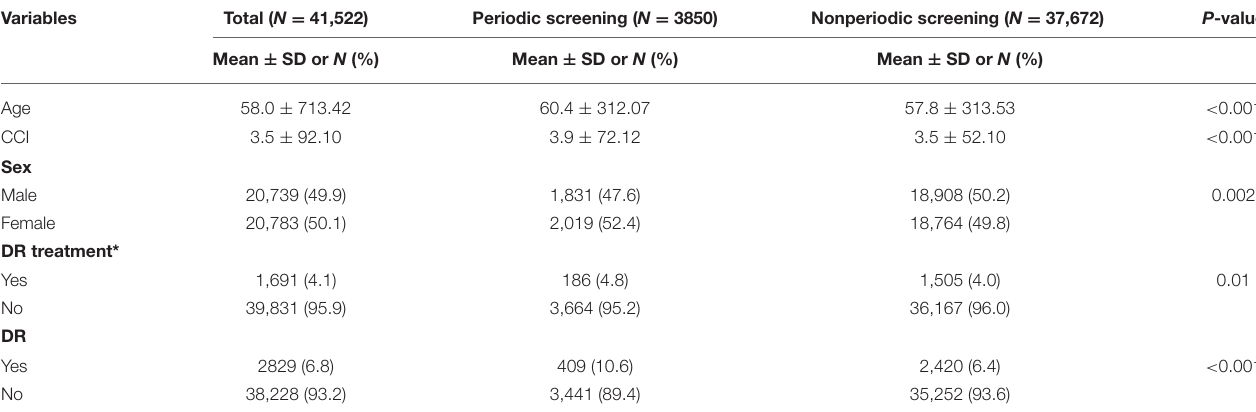
TABLE 1 | Baseline characteristics.